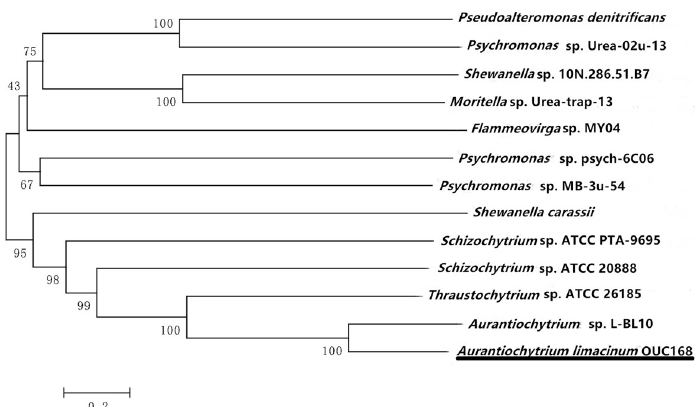
Fig 3. Phylogenetic tree of polyketide synthase in Aurantiochytrium . Numbers at the nodes represent the bootstrap values. The evolutionary distance between the groups is indicated by the scale (0.2 = 20% differences). The amino acid sequences taken from GenBank are as follows: Aurantiochytrium limacinum OUC168 (GenBank accession number MH636606), Aurantiochytrium sp. L-BL10 (AIJ29322.1), Schizochytrium sp. ATCC 20888 (AAK72879.2), Thraustochytrium sp. ATCC 26185 (AOG21004.1), Schizochytrium sp. ATCC PTA-9695 (APQ31260.1), Shewanella carassii (WP_100141973.1), Psychromonas sp. MB-3u-54 (WP_101041216.1), Psychromonas sp. psych-6C06 (WP_101109015.1), Flammeovirga sp. MY04 (WP_066209668.1), Moritella sp. Urea-trap-13 (WP_101062627.1), Shewanella sp. 10N.286.51.B7 (WP_102527861.1), Psychromonas sp. Urea-02u-13 (WP_101082395.1), and Pseudoalteromonas denitrificans (WP_091989355.1).